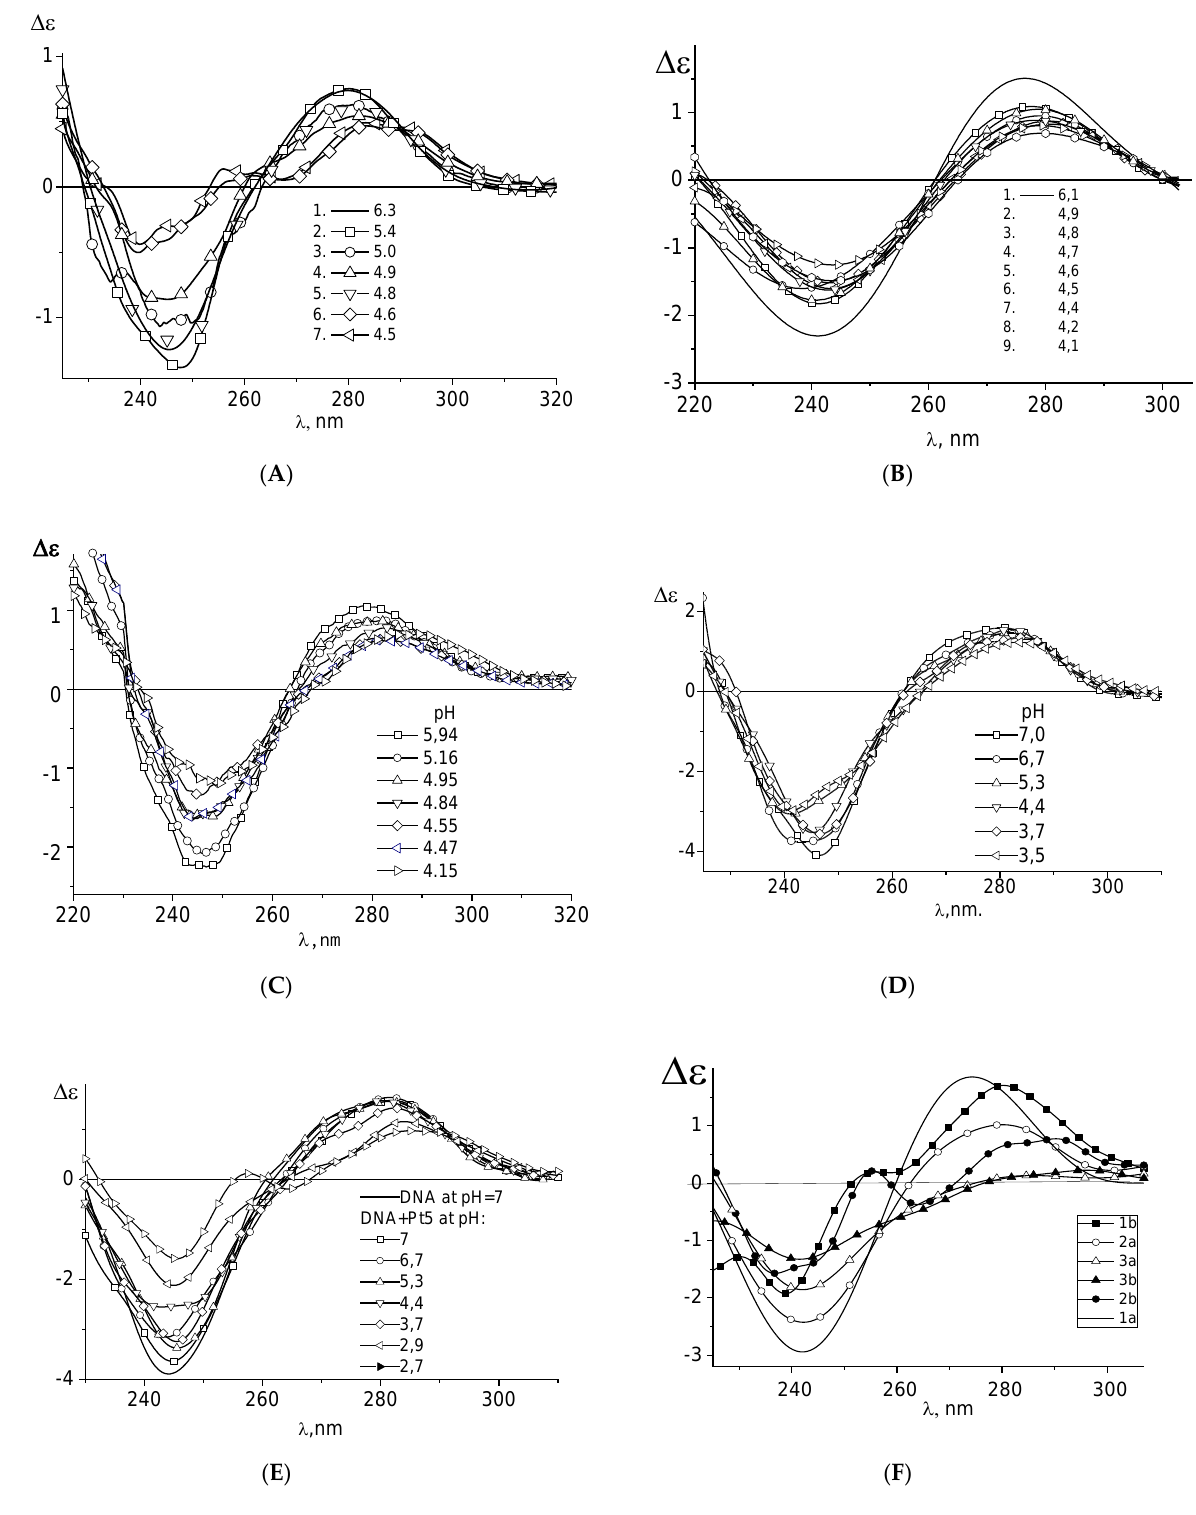
Figure 8. Circular dichroism spectra of DNA in 0.005 M NaCl ( A ) and of DNA complexes in 0.005 M NaCl with cis-DDP at C(cis-DDP) = 2.8 × 10 − 6 M ( B ); with Pt4 at C(Pt4) = 6 × 10 − 6 M ( C ); with Pt5 in 0.005 M NaCl at C(Pt5) = 5 × 10 − 6 M ( D ); with Pt5 in 1 M NaCl at C(Pt5) = 5 × 10 − 6 M ( E ), pH values are given near the lines.; and with Pt3 ( F ) in 0.005 M NaCl at C (Pt3) = 0 (1) 6 × 10 − 6 M (2) and 1.07 × 10 − 5 M (3), at pH = 6.2 (a) and 4.2